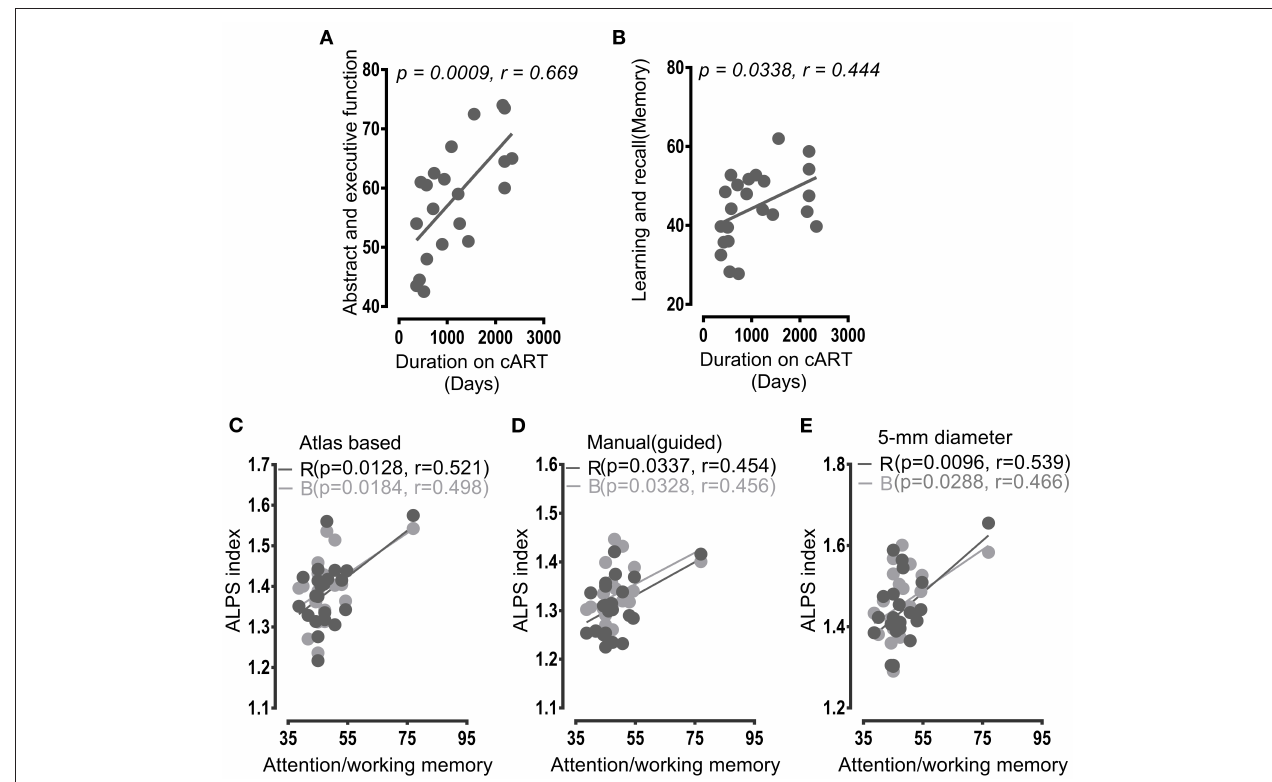
FIGURE 4 | Correlation results. (A,B) Correlations of duration on cART with neuropsychological scores of patients with HIV. The duration of cART treatment was positively correlated with cognitive performances of (A) abstract and learning function and (B) learning and recall. (C–E) Correlations between the ALPS indexes and cognitive functions in HIV patients. (C) With JHU-ICBM DTI-81 atlas-based ROIs, the right (R, gray) and bilateral (B, green) ALPS indexes demonstrated positive correlations with attention and working memory. (D) With manual DTI-guided ROIs, positive relationships were also exhibited between attention/working memory and ALPS indexes of the right and the combined perivascular spaces (PVSs). (E) With 5-mm-diameter ROIs, similar correlations were manifested between the right and bilateral indexes and the attention and working memory neuropsychological scores. All tests in correlation analyses were significant at p < 0.05. R, right; B, bilateral. The term “bilateral index” refers to an index computed by combining ROIs of both sides (right and left) of the